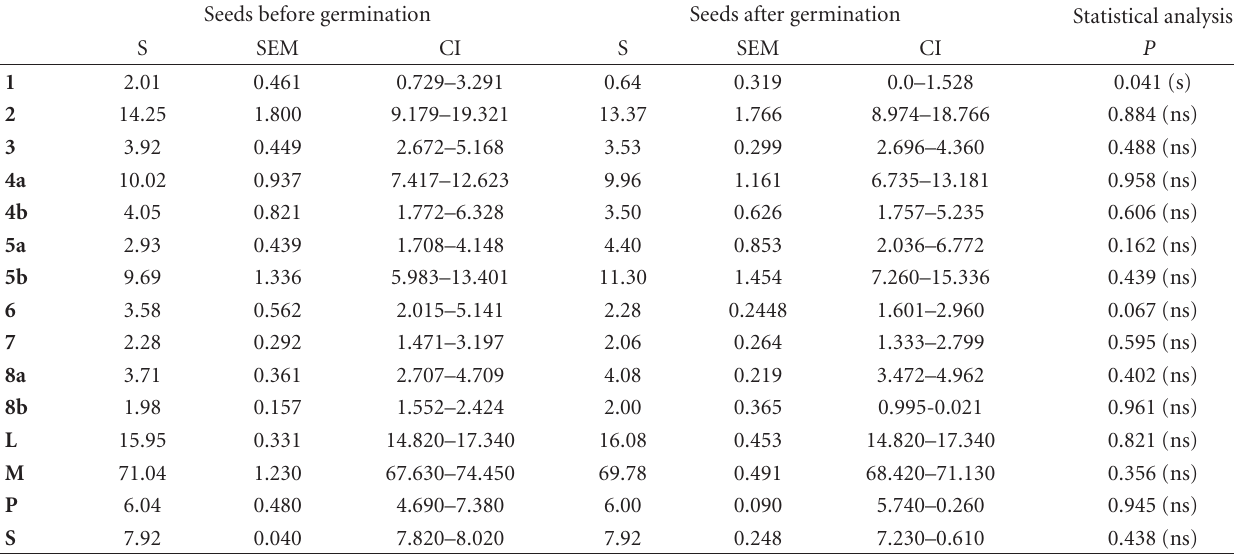
Table 2: Relative contents of secondary metabolites and fatty acids in V. surinamensis seeds. Seeds before germination Seeds after germination Statistical